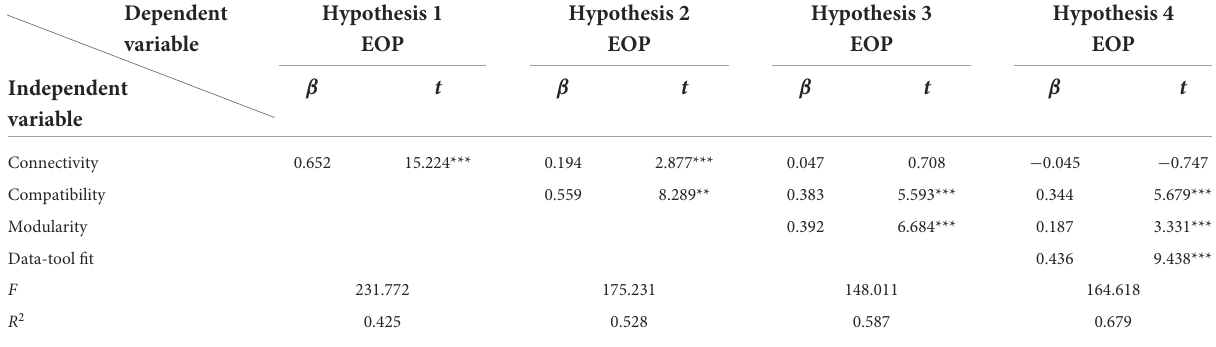
TABLE 7 Coefficients